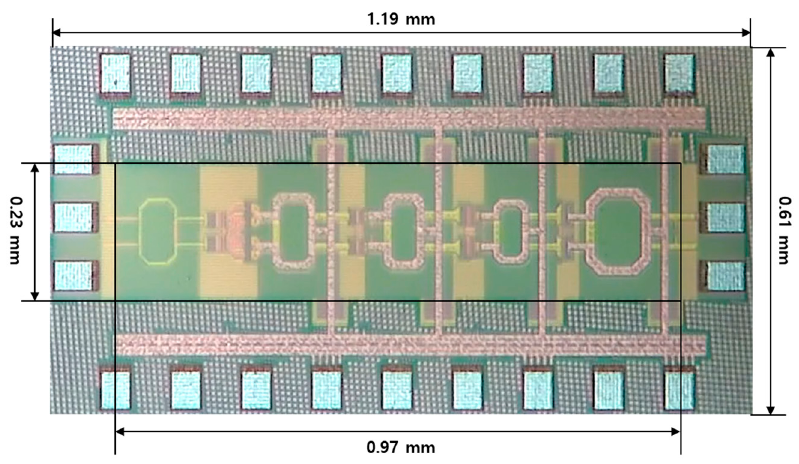
Figure 7. Photograph of the designed CMOS power amplifier.